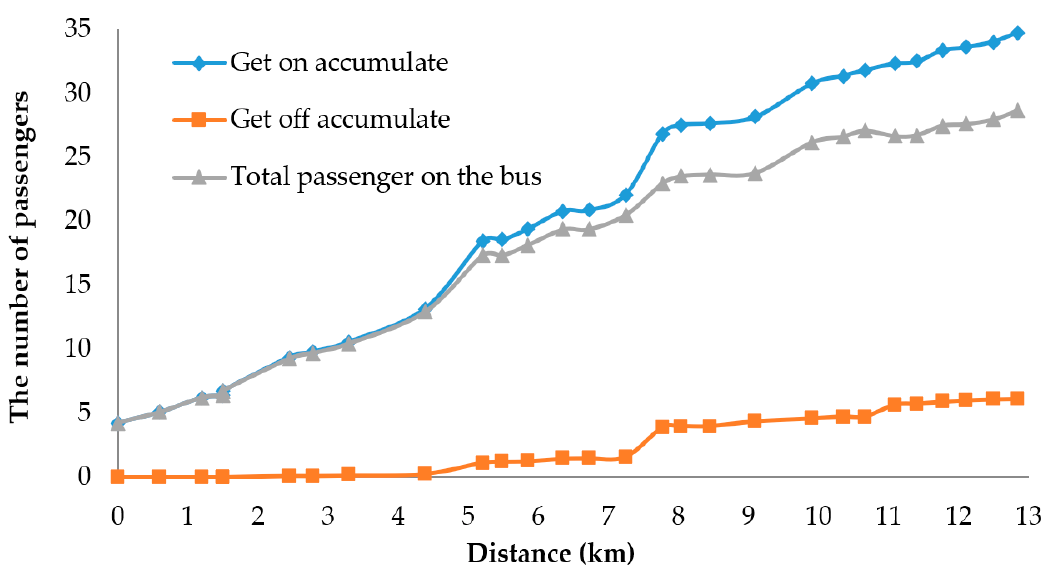
Figure 4. Inbound Passenger Load Profile from Samaedam Terminal (distance = 0 km) to Rama 2 T-junction.